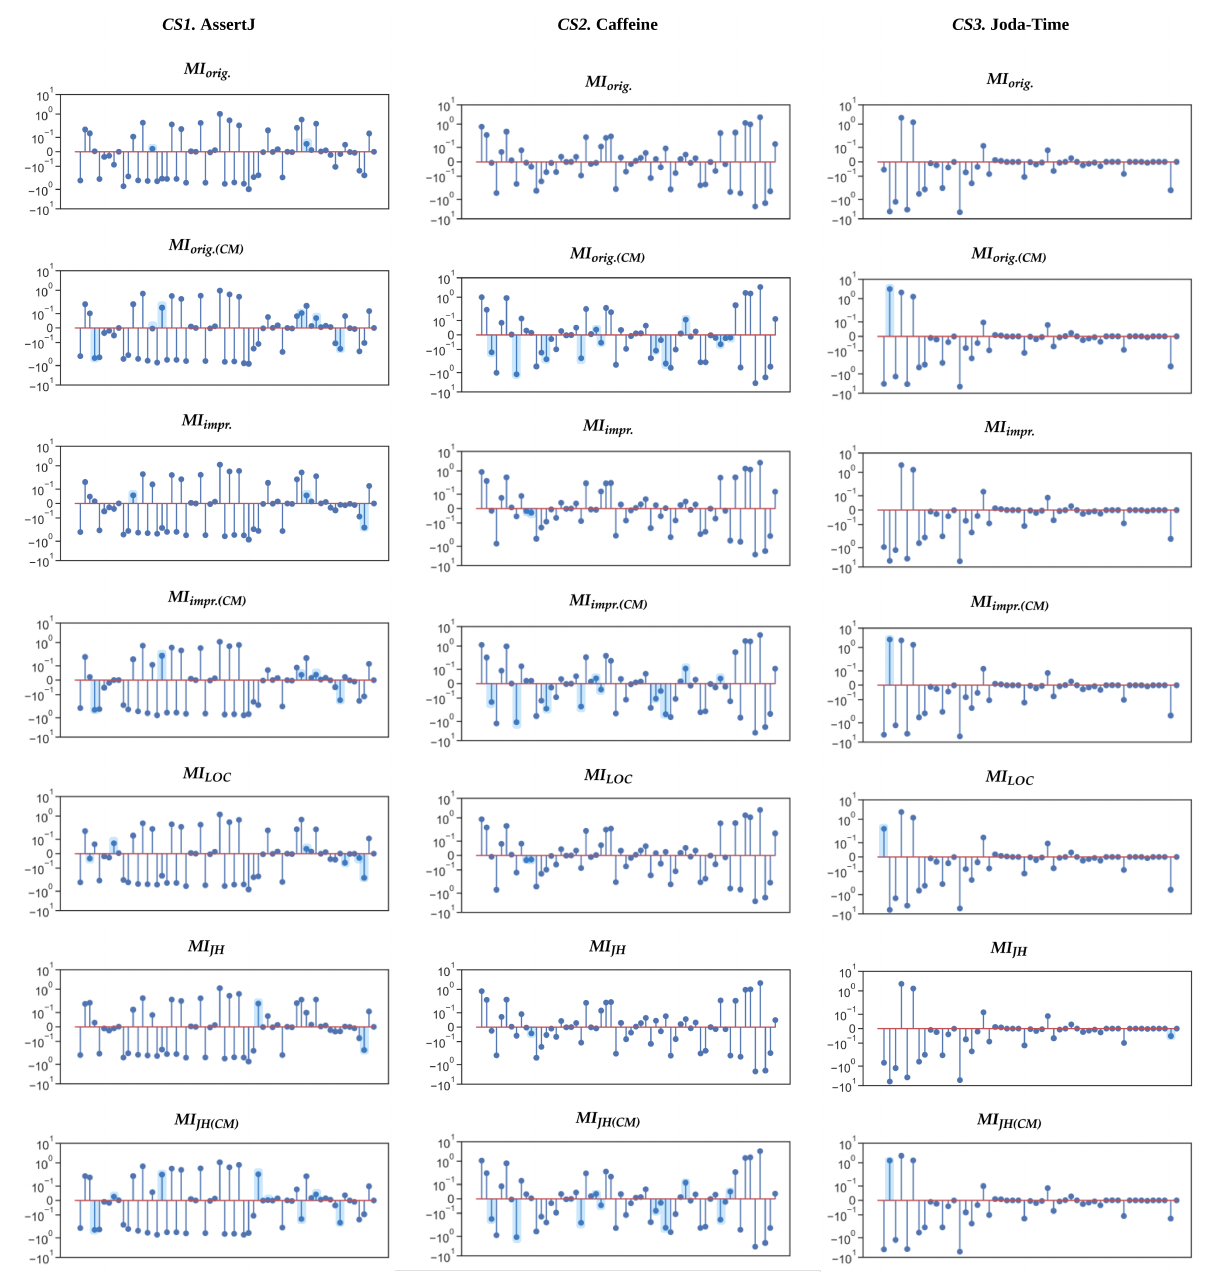
Figure 9. Lollipop plots depicting the change in Index variants’ values from the previous